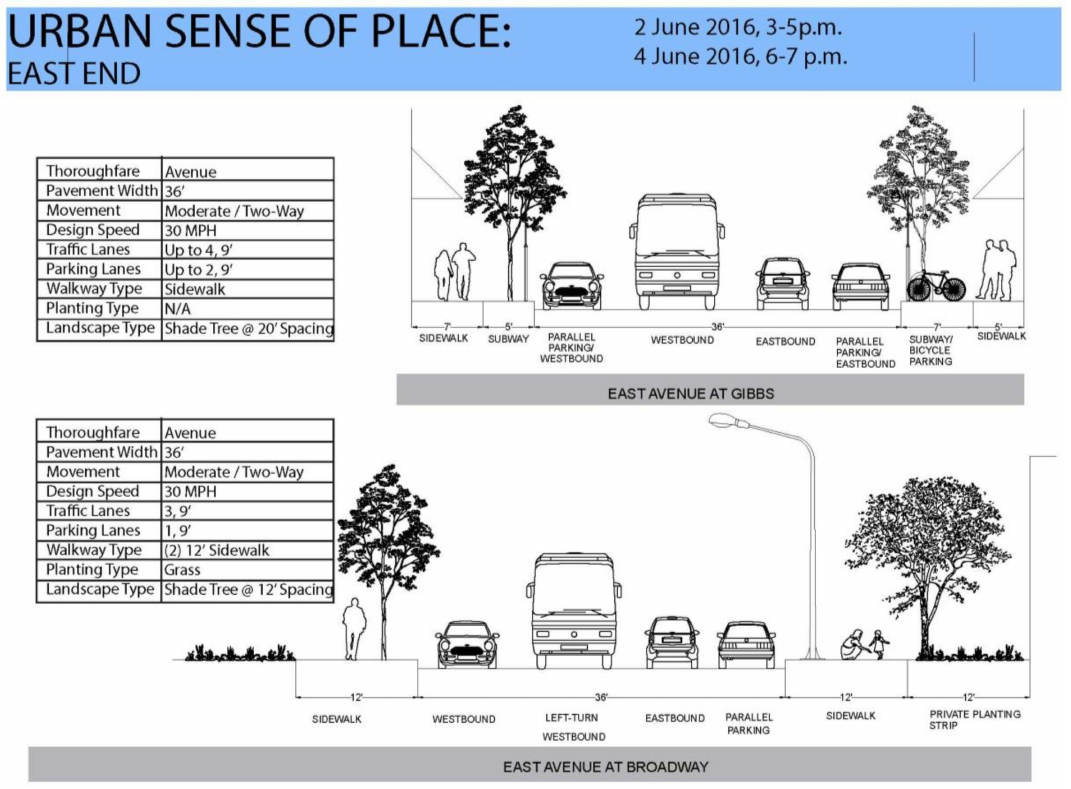
Figure 9. East End street sections (by